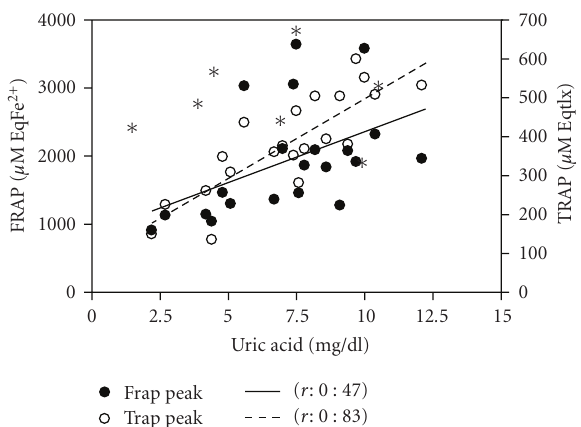
Figure 3: Correlations of peak FRAP and TRAP levels with peak uric acid levels. P < . 05 for both correlations